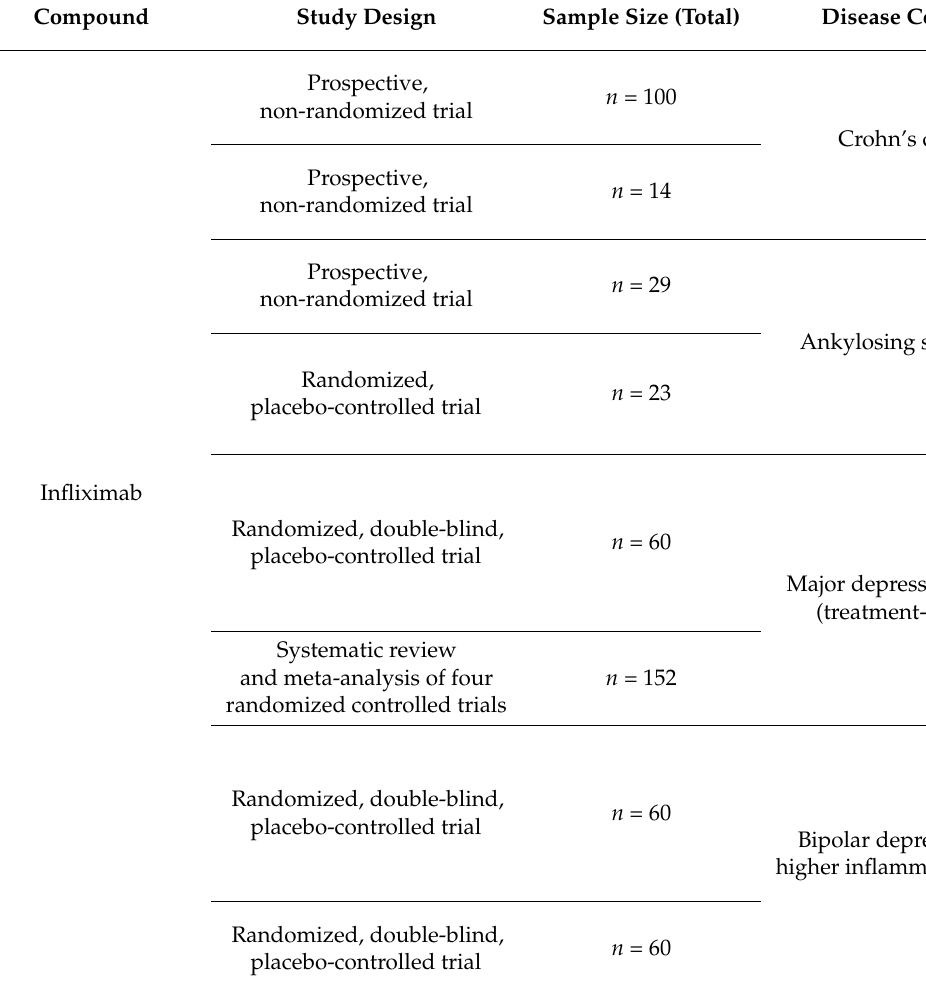
Table 1. Summary of clinical trials reporting on the mood-modulating effects of anti-TNF- α compounds in patients with various disease conditions.